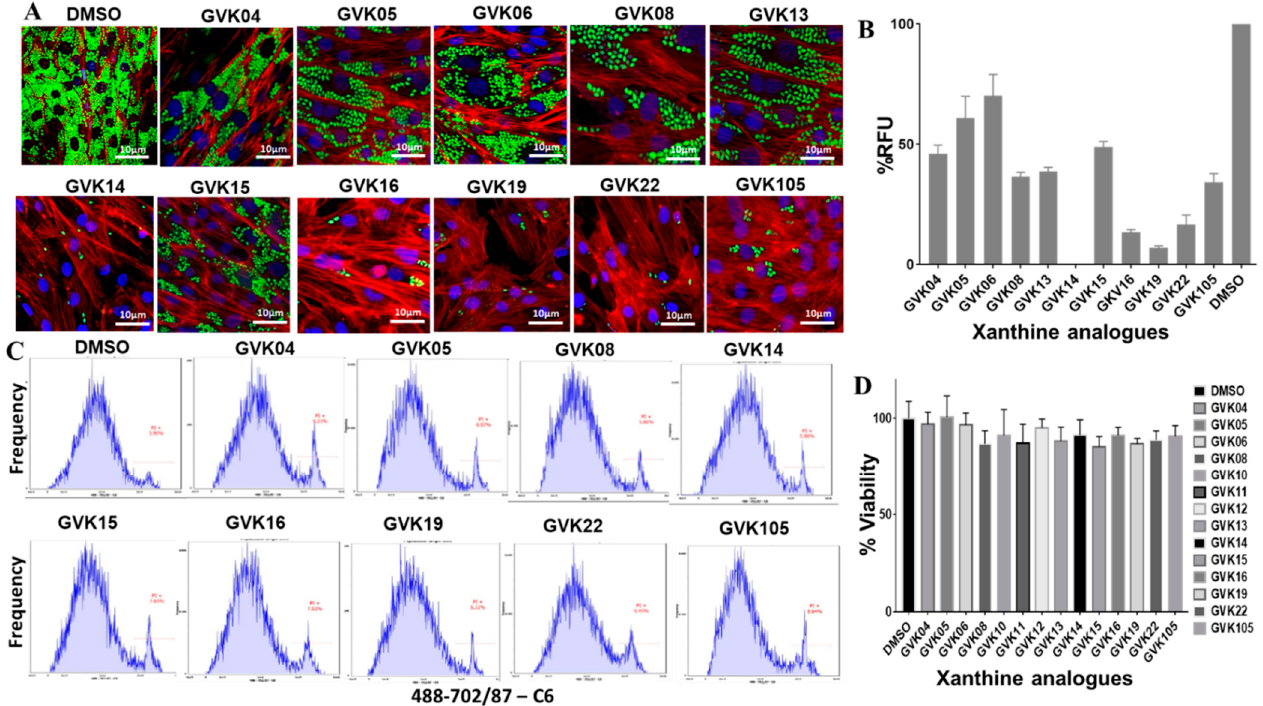
Figure 2. IBMX analogs inhibit T. cruzi infection in vitro. ( A ) Fluorescent microscopic images of RHM infected with T. cruzi (Tulahuen strain) expressing GFP. RHMs were treated with 50 nM of IBMX analogs, and parasite infection was evaluated after 24 h. Green fluorescence represents actively growing T. cruzi amastigotes inside the cells. ( B ) Graphs were created based on green fluorescence intensity, which is measured as % RFU intensity, and DMSO control is shown as 100%. ( C ) FACS analysis of the infected cells with the respective inhibitors represents cellular toxicity using annexin V-PI staining. ( D ) CCK-8 assay for cell viability or cytotoxicity after treatment with 100 nM of xanthine compounds on RHM cells. Data are analyzed as mean ± standard deviation (SD) ( n = 3) for CCK-8